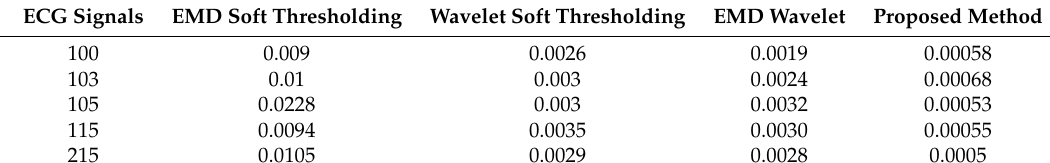
Table 7. Comparison of the MSE obtained by using different denoising methods.